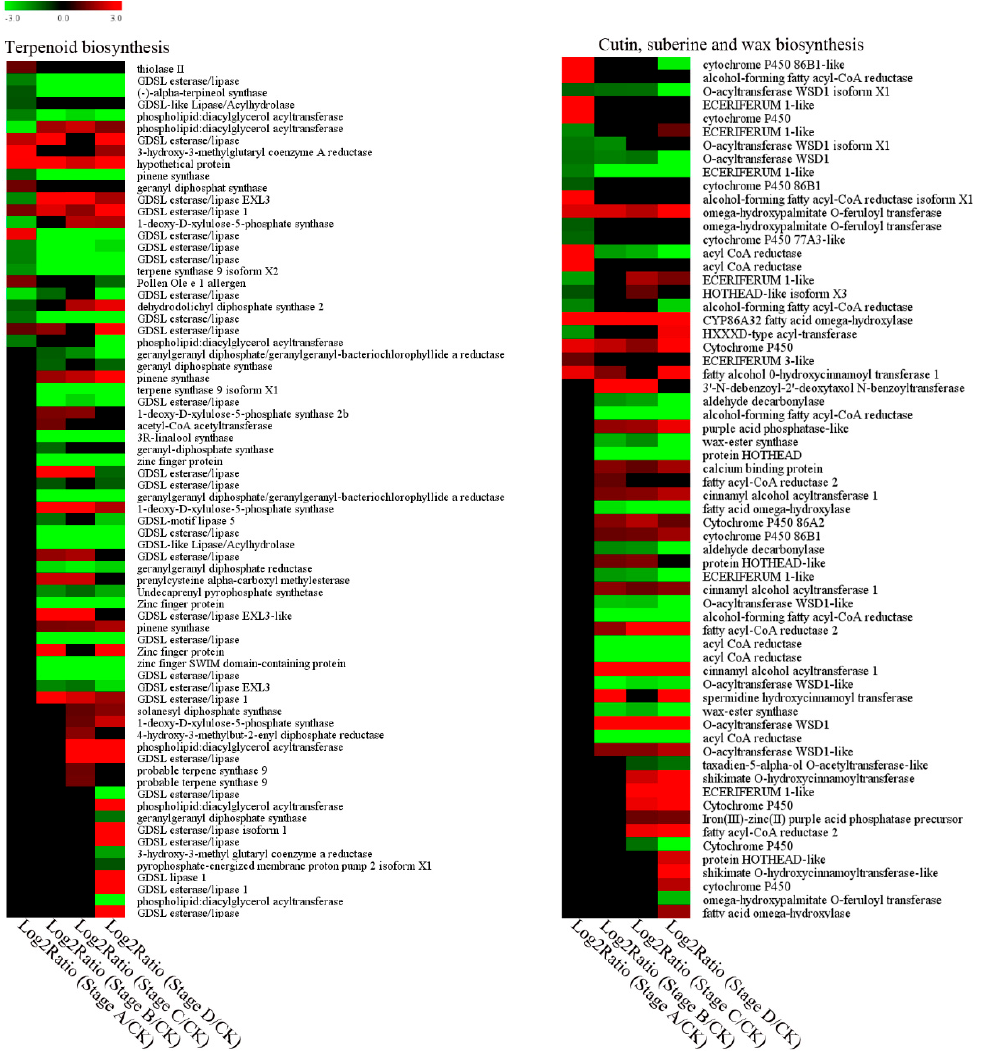
Figure 8. Expression profiles of DEGs involved in terpenoid biosynthesis and cutin, suberine and wax biosynthesis.